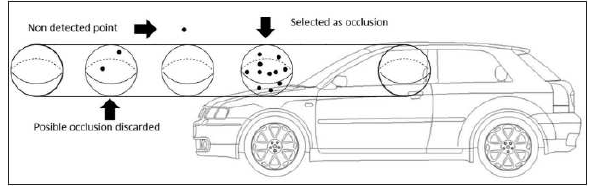
Figure 2. Representation showing how the algorithm applies the occlusion condition. (Iglesias et al., 2016).